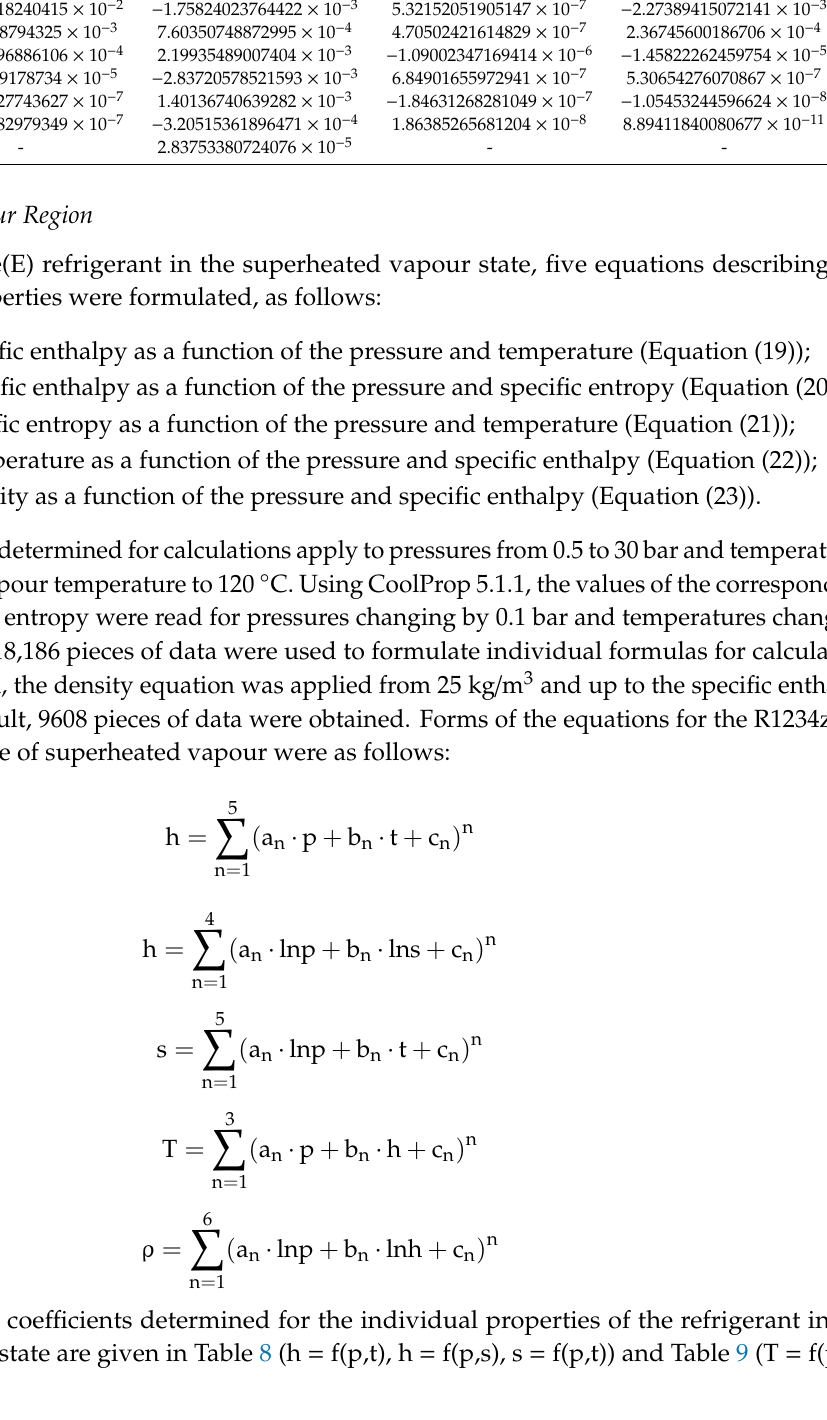
Table 7. Coe ffi cients of polynomials describing the specific volume, heat transfer coe ffi cient, dynamic viscosity coe ffi cient, and Prandtl number of the R1234ze(E) refrigerant in the saturated vapour state. Equation Coef ν ” = f(p) λ ” = f(p) µ ” = f(p) Pr” = f(p) (15) (16) (17) (18) a 0 1.77433953172014 × 10 − 1 1.00685420897056 × 10 −